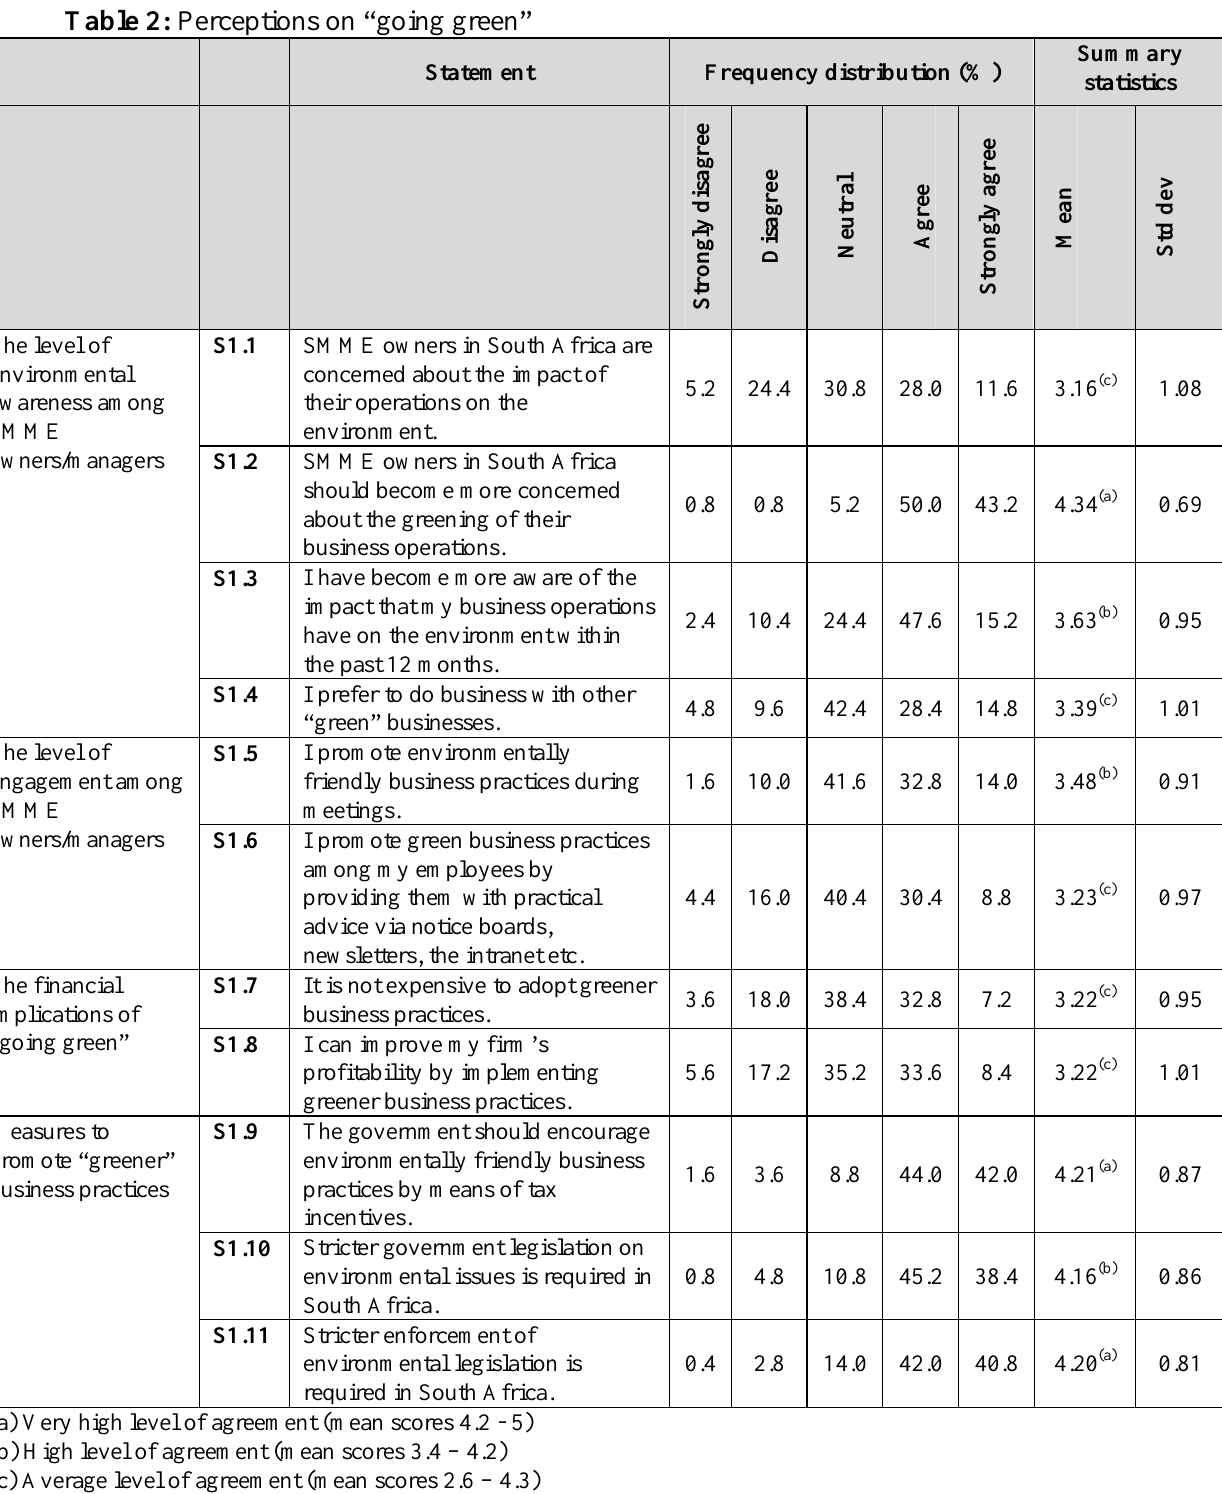
Table 2 indicates the frequency distributions and summary statistics of the statements contained in Section A of the questionnaire. Table 2: Perceptions on “going